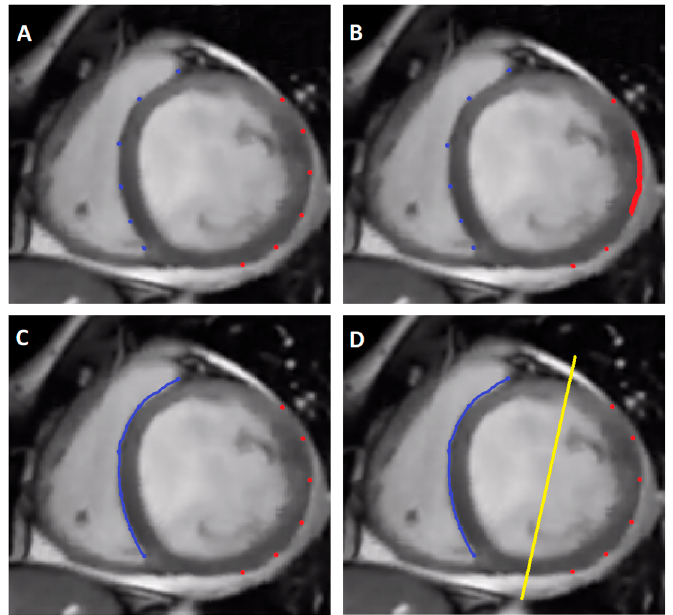
Figure 3. Schematic presentation of HOT-CRT concept vs. standard CRT. ( Panel ( A )): blue dots–RV pacing sites, red dots–LV pacing sites in CRT. To achieve optimal resynchronization the anatomic location of RV and LV leads should be exactly opposite which is not achievable for each patient. ( Panel ( B )): the red-marked area on the left ventricle indicates the most successful resynchronization LV electrode placement site. If the given patient does not have an appropriate target vein in this region the procedure result will not be optimal. ( Panel ( C )): In HOT-CRT concept the blue line represents RV activation area originating from His Bundle pacing via right bundle branch. ( Panel ( D )): Optimal resynchronization results from achieving perfect fusion of activation fronts coming from right and left site, as depicted by the yellow line. This effect is much more probable in HOT-CRT approach.